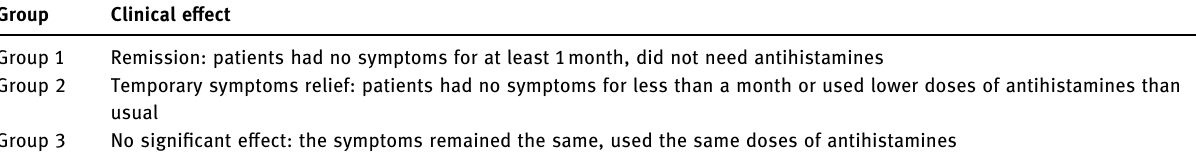
Table 2: Patient groups depending on clinical e ff ect Group Clinical e ff